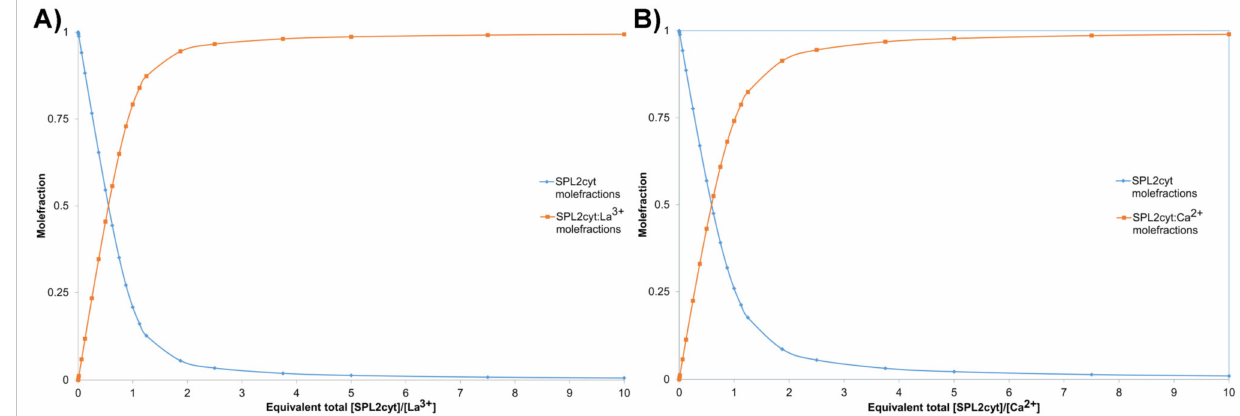
Figure A3. The stoichiometry of binding between the SPL2cyt protein and ( A ) La 3+ and ( B ) Ca 2+ . Data were fitted using supramolecular.org [51].